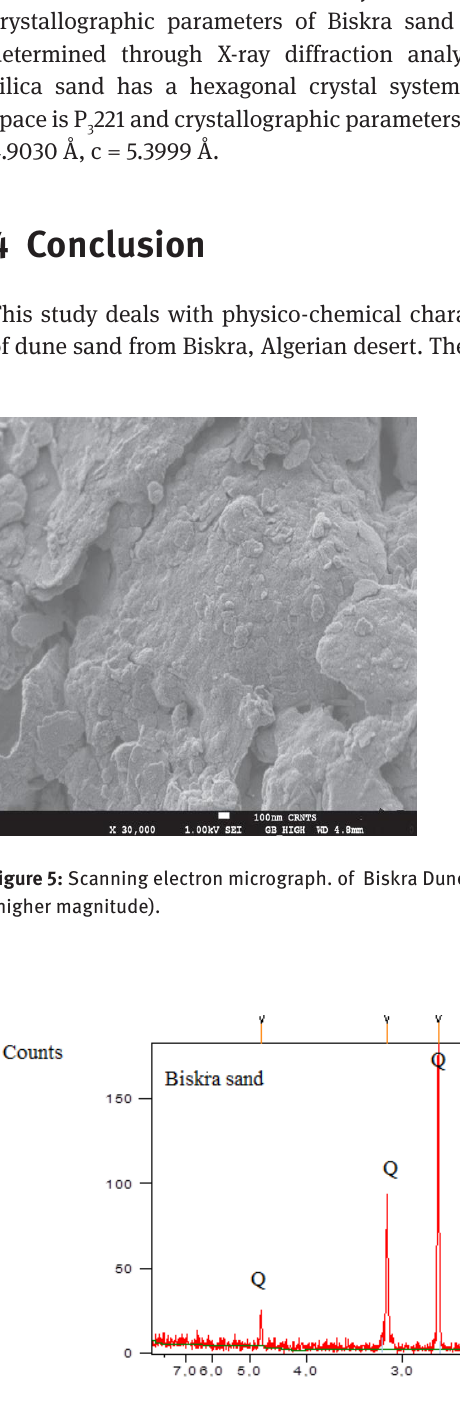
Figure 6: XRD spectrum of Biskra sand.